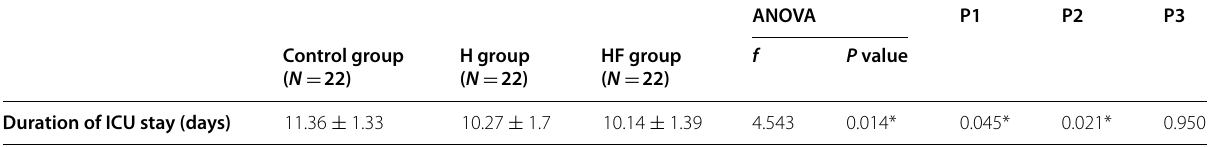
Table 3 Comparison between the three groups regarding the duration of ICU stay